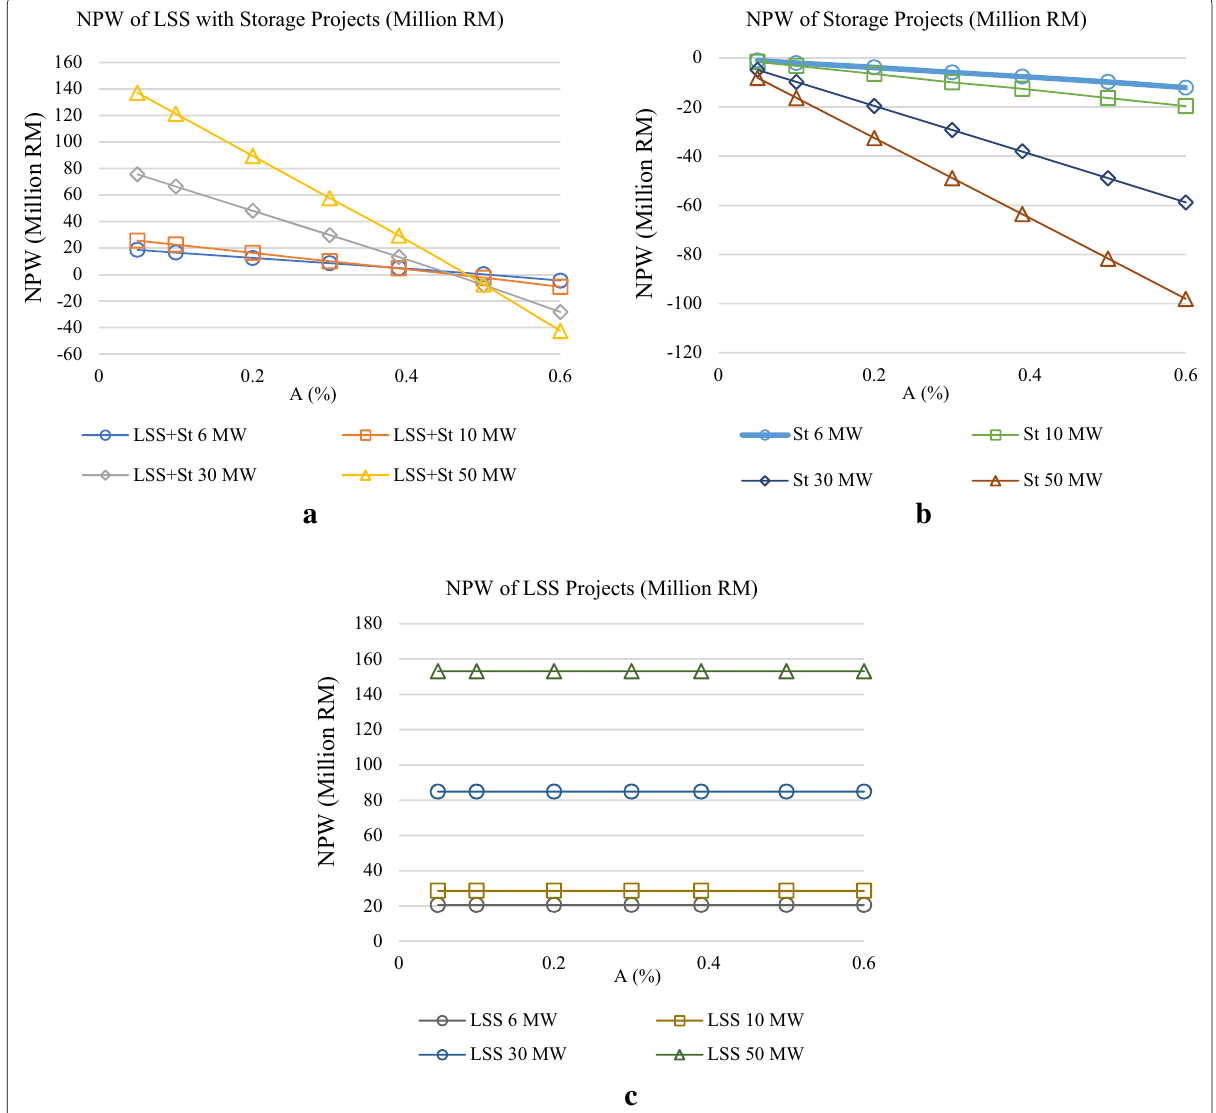
Fig. 11 Net present worth of different LSS capacities with variation of “ A ” in Perak. a LSS with storage projects, b storage projects and c LSS